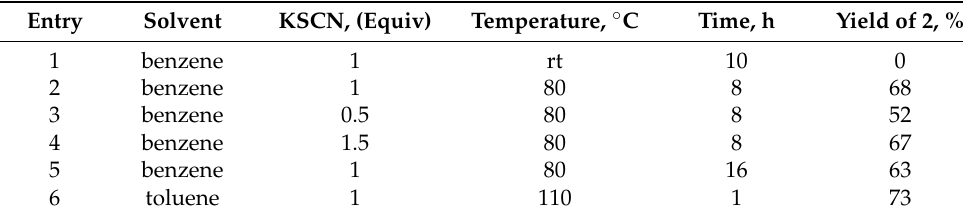
Table 1. Reaction of 4,5-dichloro-3 H -1,2-dithiole-3-thione 1 with KSCN.